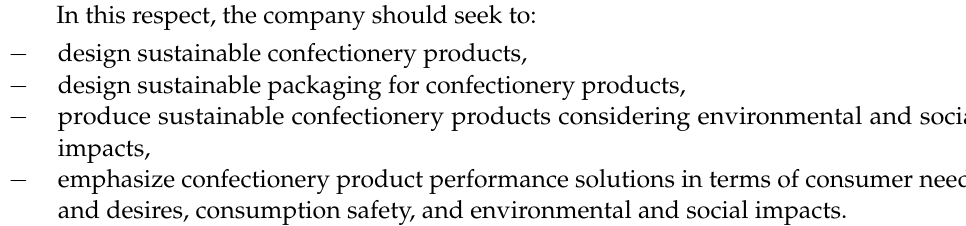
Figure 5. Procedure for implementing sustainable marketing mix of confectionery products.